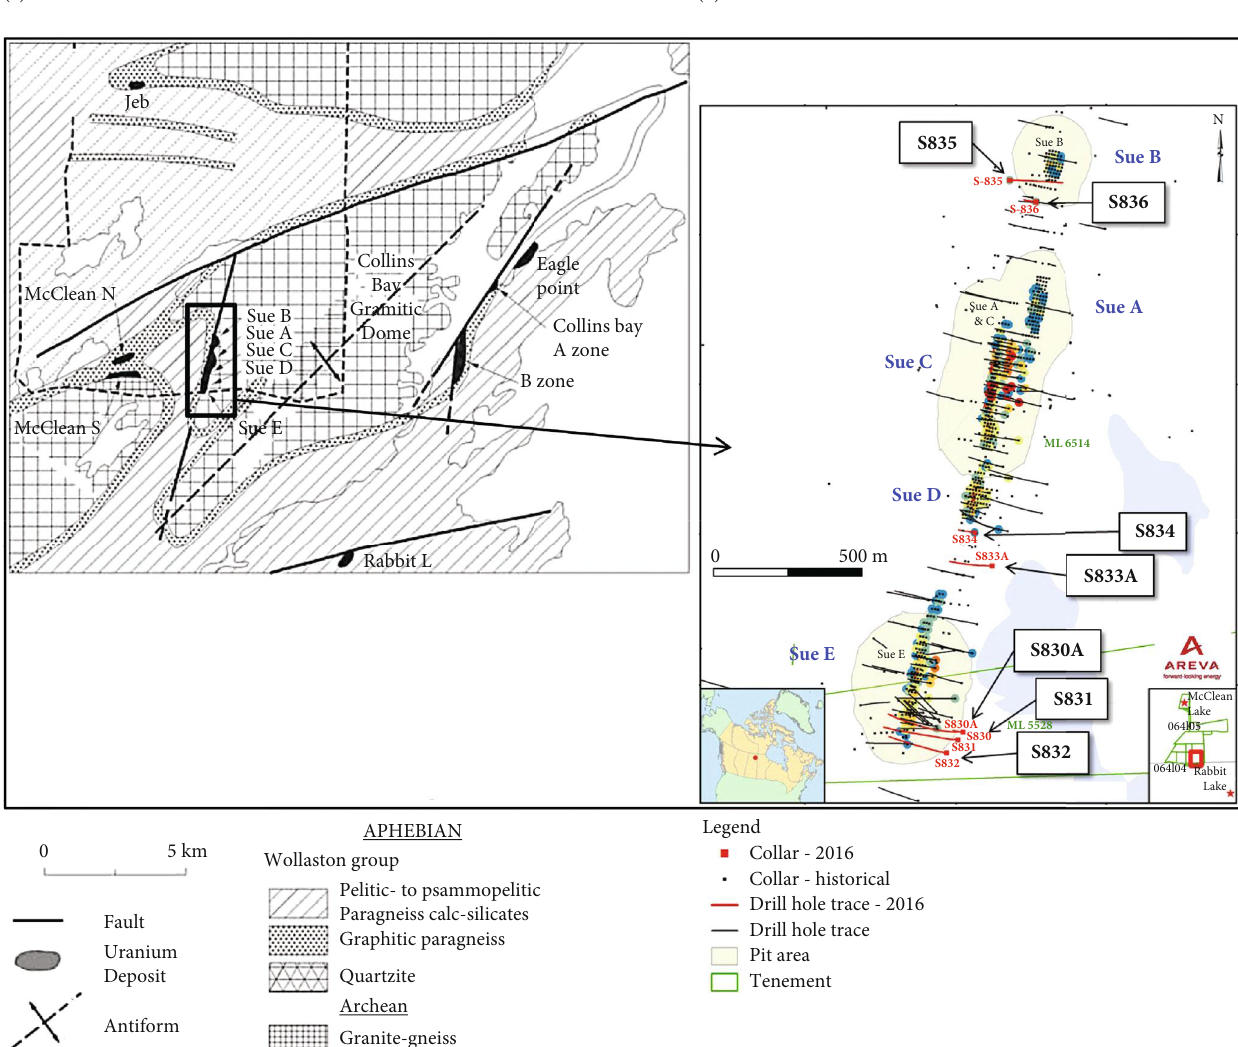
Figure 3: (a) Regional framework of the Sue uranium deposits, McClean Project (originally from [18]; modi fi ed from [48]). (b) Location of the 2016 drilled exploration holes (Orano